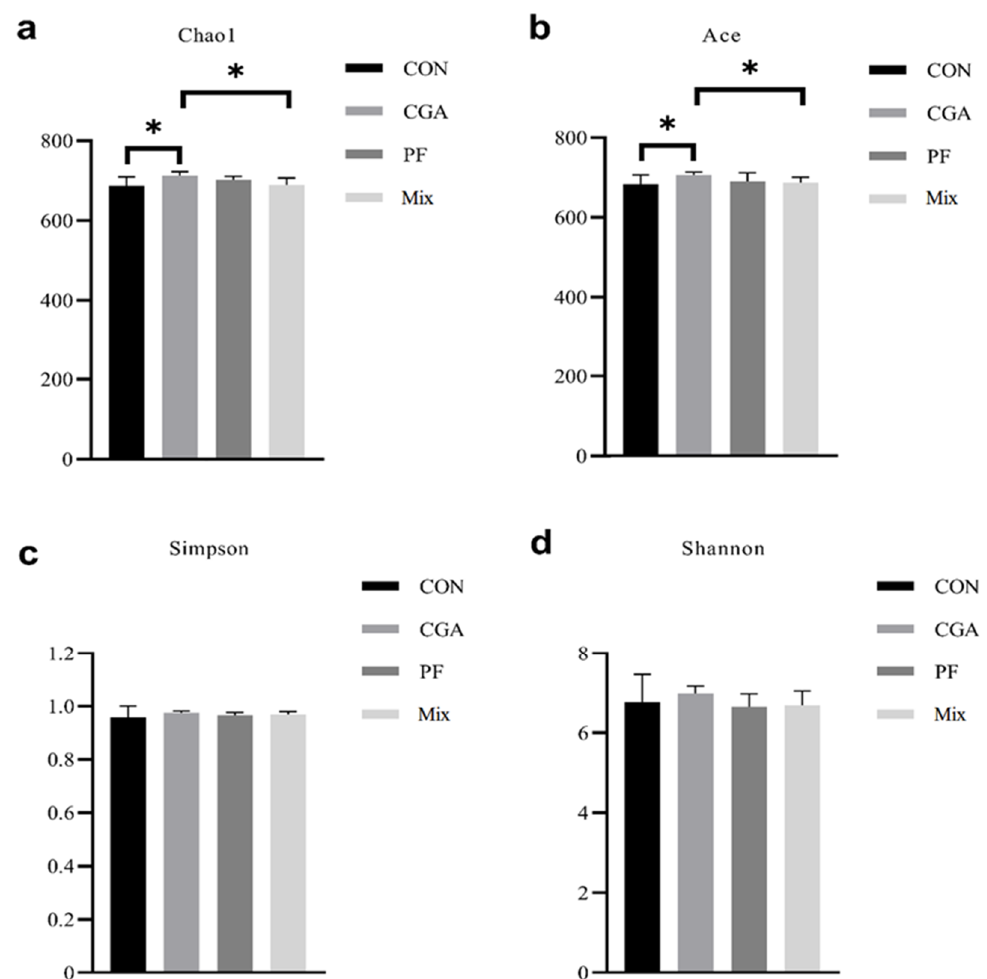
Figure 4. α diversity analysis of rectal microbes in finishing pigs. ( a ) Chao1 index, ( b ) Ace index, ( c ) Simpson index, and ( d ) Shannon index. All bar charts show means ± SD, * = p < 0.05, n = 9 in each group.